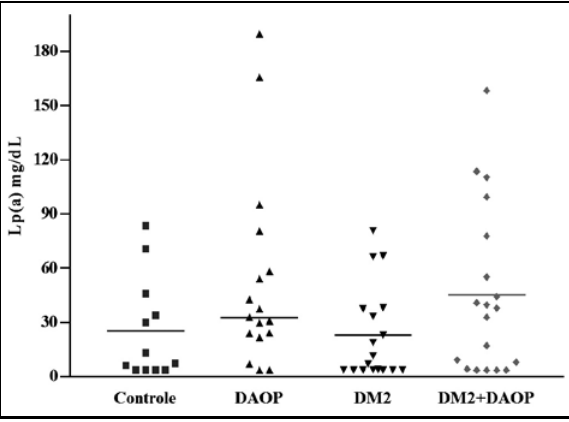
Figura – Distribuição dos valores Lp(a). Valores expressos em mg/dl para os grupos controle, DAOP, DM2 e DM2 + DAOP. O valor desejável de Lp(a) é inferior a 30 mg/dl. As linhas horizontais representam as medianas dos grupos. Não foi observada diferença significativa entre as medianas dos grupos estudados Lp(a): lipoproteína (a); DAOP: doença arterial obstrutiva periférica; DM2: diabetes mellitus tipo